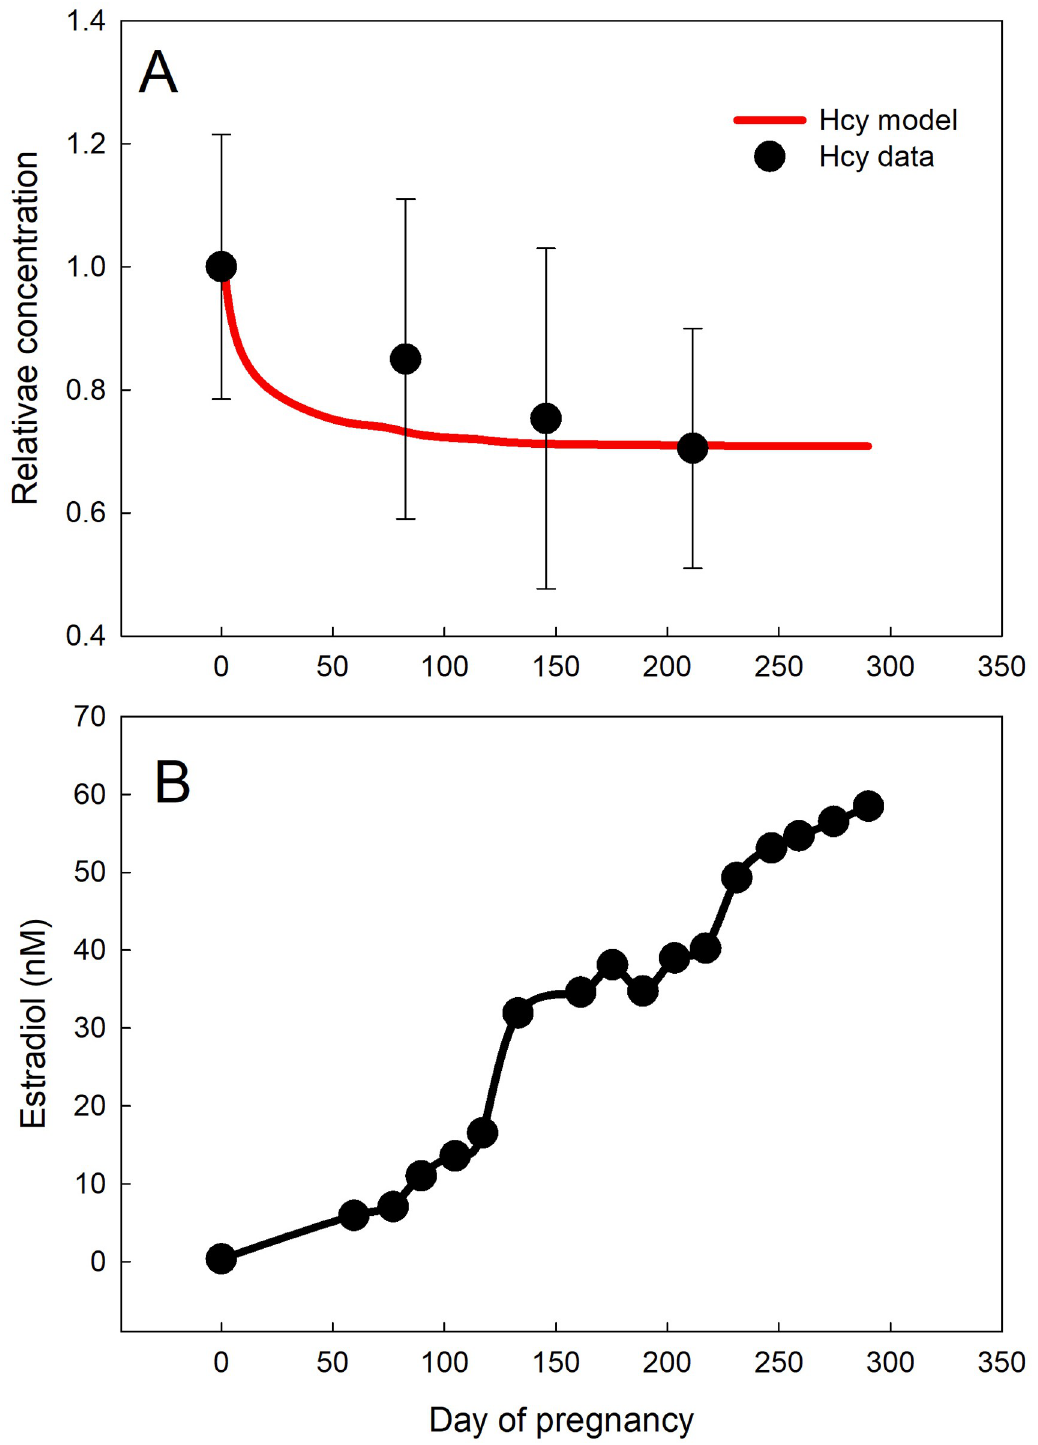
Fig 6. Homocysteine throughout pregnancy. Estradiol (E2) increases significantly from about 0.35 nM to 58.46 nM throughout pregnancy [7, 11]. The E2 data from [11] is reproduced in Panel B. Our model predicts Hcy throughout pregnancy as a result of E2 changes. Hcy is plotted relative to its concentration in menstruating women (red curve, Panel A). Our model corresponds well with data from [52], which is also plotted relative to Hcy in menstruating women (black dots, Panel A). The black bars indicate standard